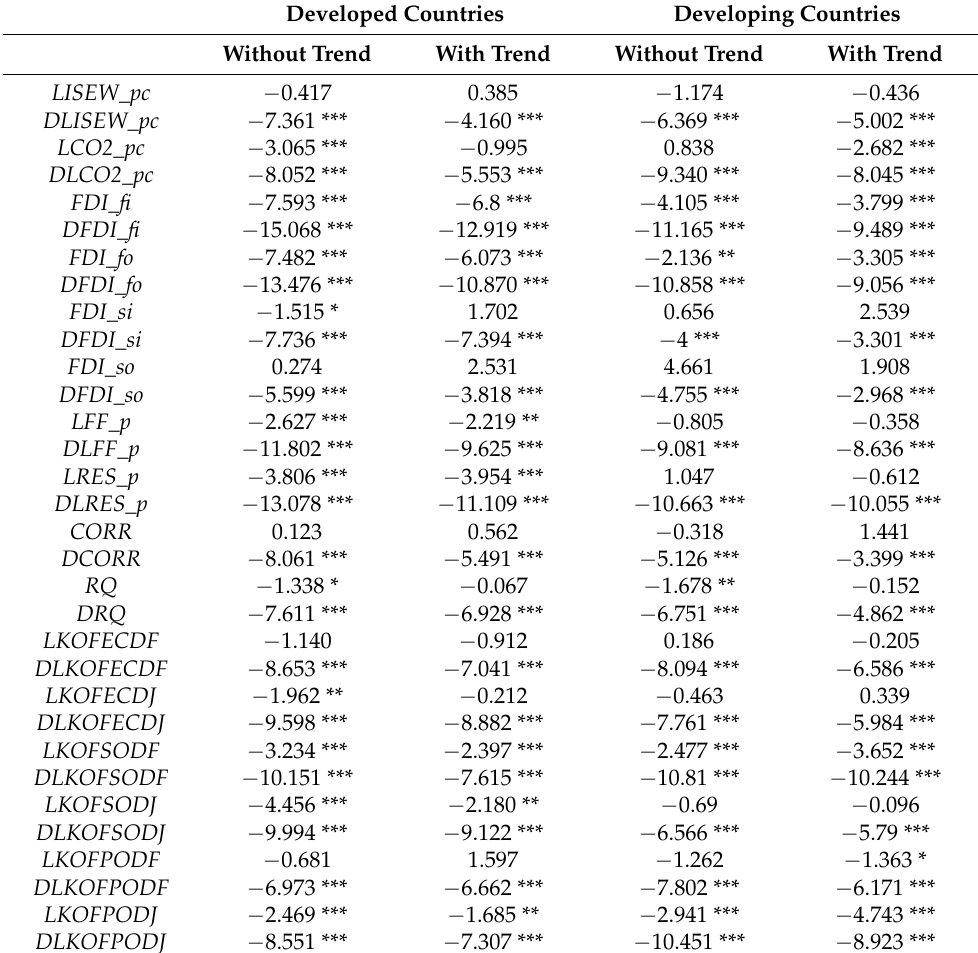
Table 8. Second-generation unit root test (CIPS) from 2000 to 2017 (ISEW model). Developed Countries Developing Countries Without Trend With Trend Without Trend With